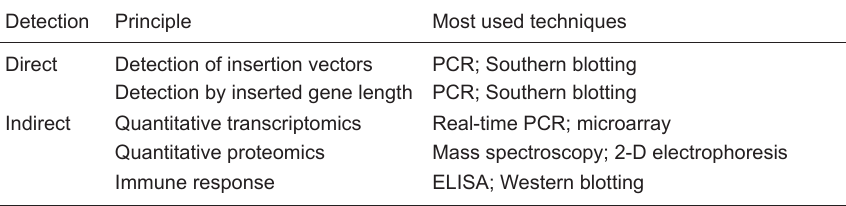
Table 1. Methods for the detection of gene